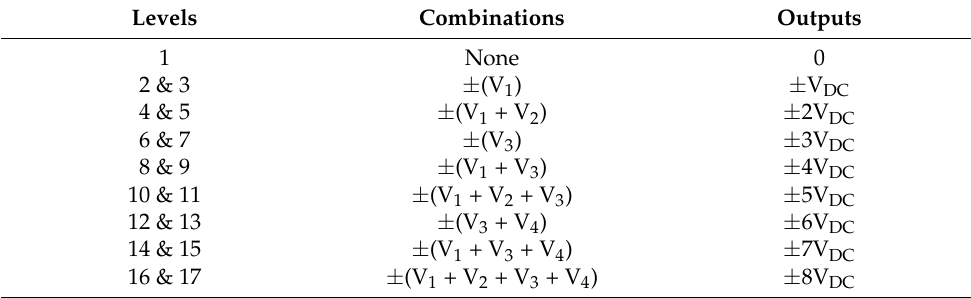
Table 1. Voltage source combinations for 17 L